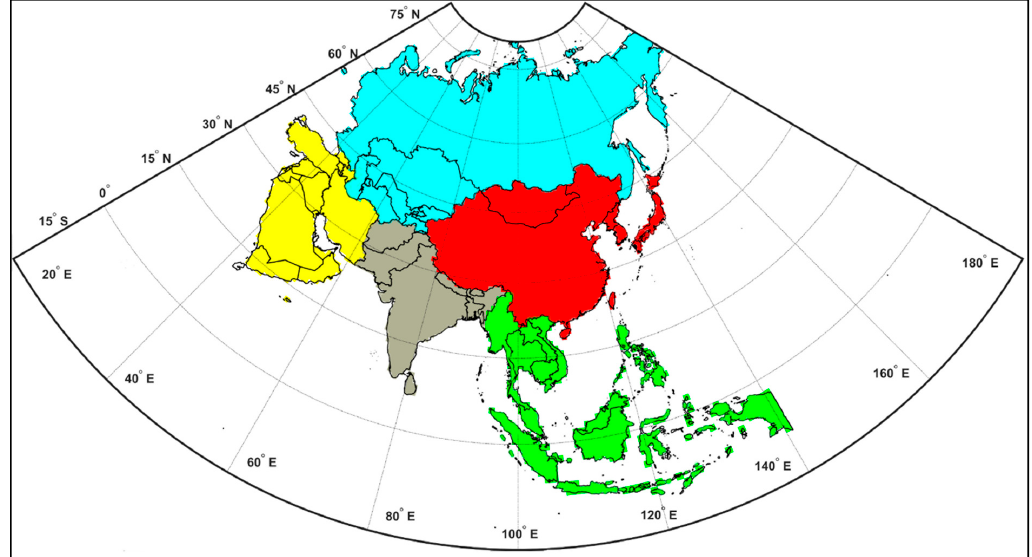
Figure 1. The Mediterranean-Asia which included 45 countries was categorized into five sub-regions in this study as the followings: East Asia (red), Central and North Asia (light blue), West Asia (yellow), South Asia (gray), and Southeast Asia (green).